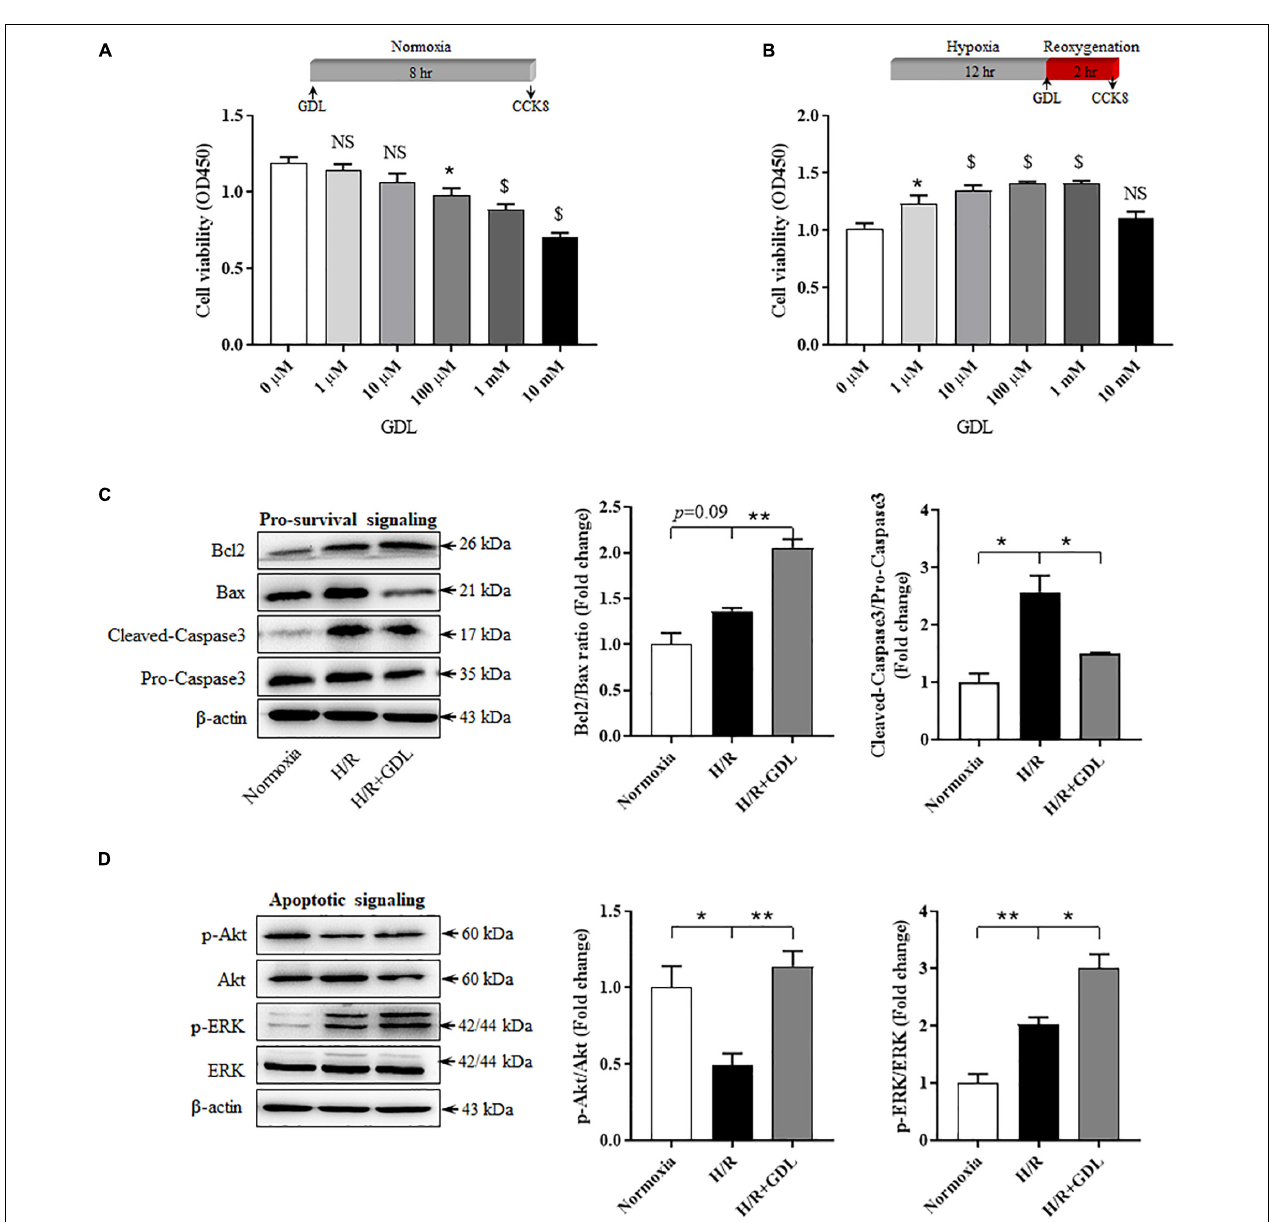
FIGURE 4 | D-glucono-1,5-lactone enhanced cell viability of NRCM following H/R injury. (A) Dose-dependent effect of GDL (0 µ M, 1 µ M, 10 µ M, 100 µ M, 1 mM, and 10 mM) on cell viability of NRCM cells by CCK-8 test. (B) Dose-dependent effect of GDL (0 µ M, 1 µ M, 10 µ M, 100 µ M, 1 mM, and 10 mM) on cell viability of H/R-injured NRCM cells by CCK-8 test. (C) Representative images and Western blot analysis of apoptosis-related proteins (Bcl2, Bax, and Caspase3) in normoxia, H/R and H/R + GDL groups. (D) Representative images and Western blot analysis of pro-survival kinases (ERK and Akt) among groups. * P < 0.05, ** P < 0.01, and $ P < 0.0001 between indicated groups. Data shown are representive of five independent